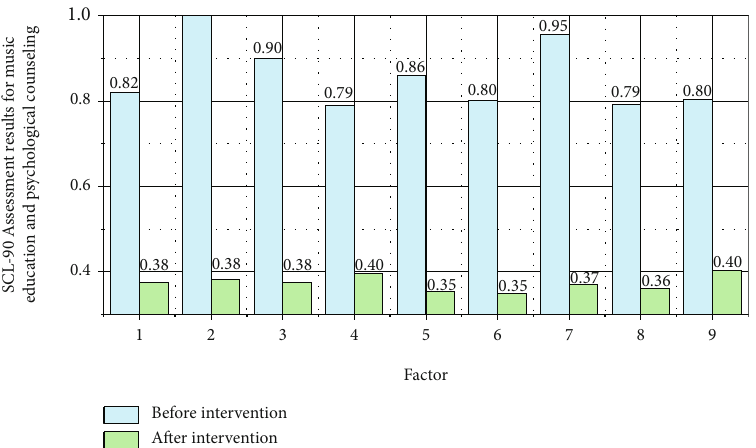
Figure 4: Comparison of SCL-90 assessment results before and after music education and psychological counseling.